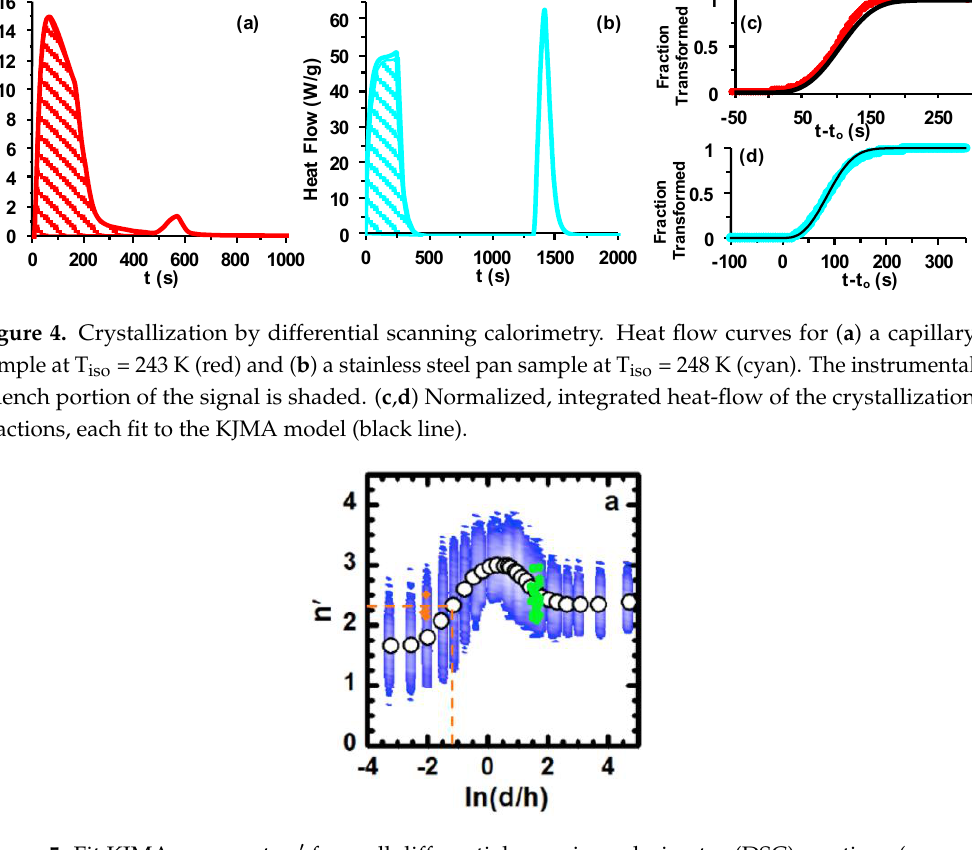
Figure 5. Fit KJMA exponents n ′ from all differential scanning calorimetry (DSC) reactions (orange capillary and green pan) superimposed on top of the fixed volume simulation Figure 6a from reference [9] to estimate the actual sample d/h anisotropy. Orange dashed line represents the apparent aspect ratio for the capillary samples.